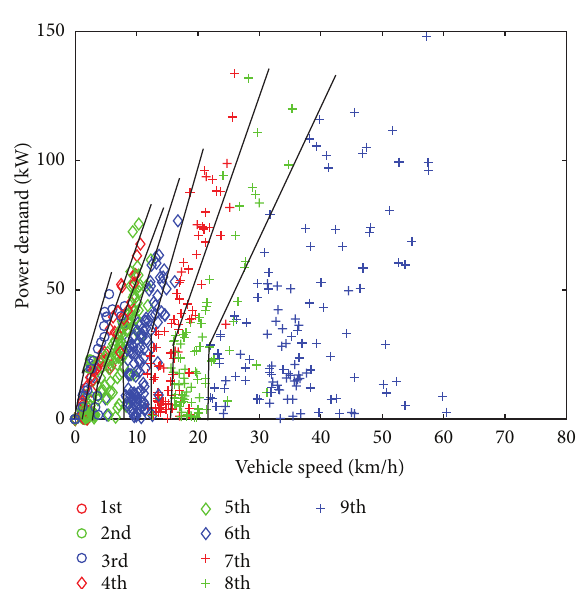
Figure 10: DP-based gear operating points.